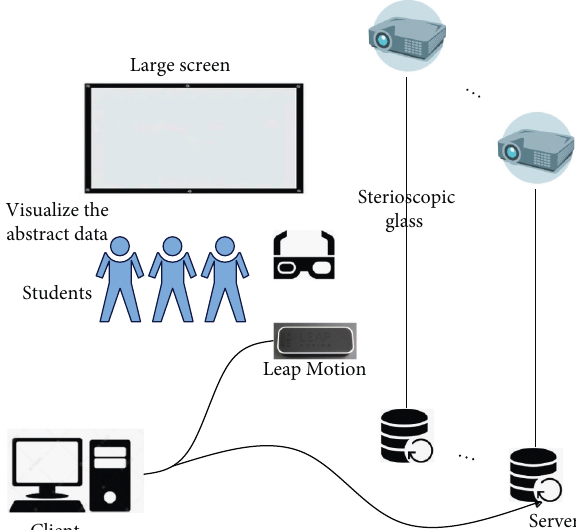
Figure 10: Schematic diagram of immersive VR physics teaching